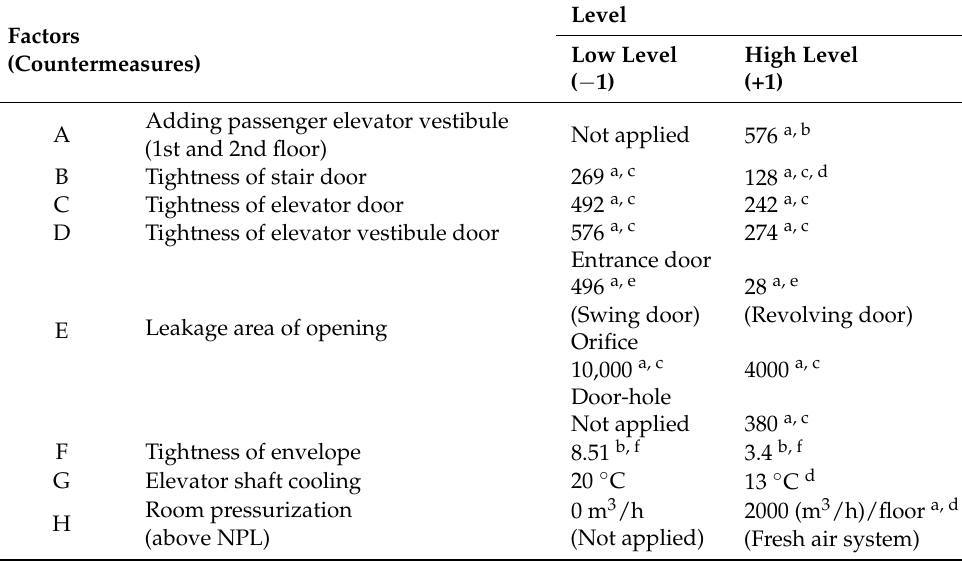
Table 1. The settings of